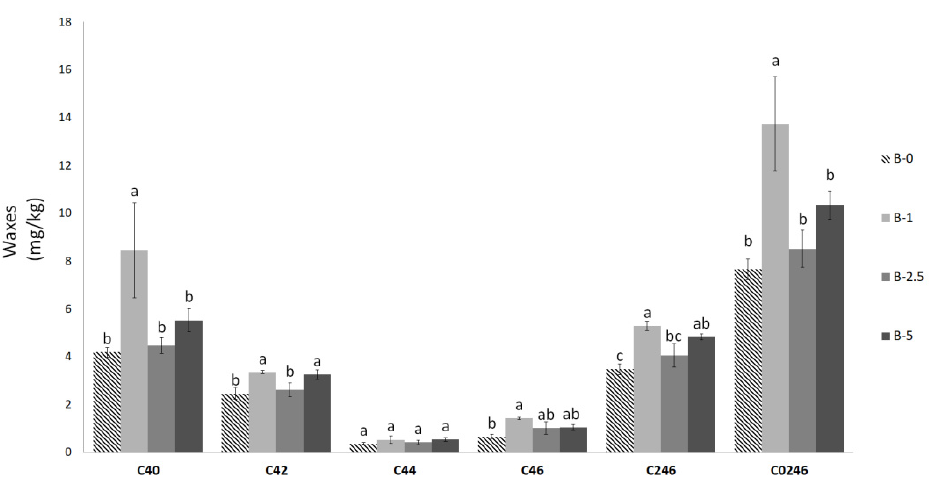
Figure 3. Concentrations (mg/kg) of waxes (C40, C42, C44, and C46) as well as C246 (sum of C42, C44 and C46 waxes) and C0246 (sum of C40, C42, C44, and C46) in Buža olive cultivar oil obtained without (B-0) and with the addition of different amounts of olive leaf: 1% (B-1), 2.5% (B-2.5) and 5% (B-5). Results represent mean values of three technical repetitions ± standard deviations. Different letters above bars represent significant differences among the treatments (Tukey ´ s test, p < 0.05) for each parameter